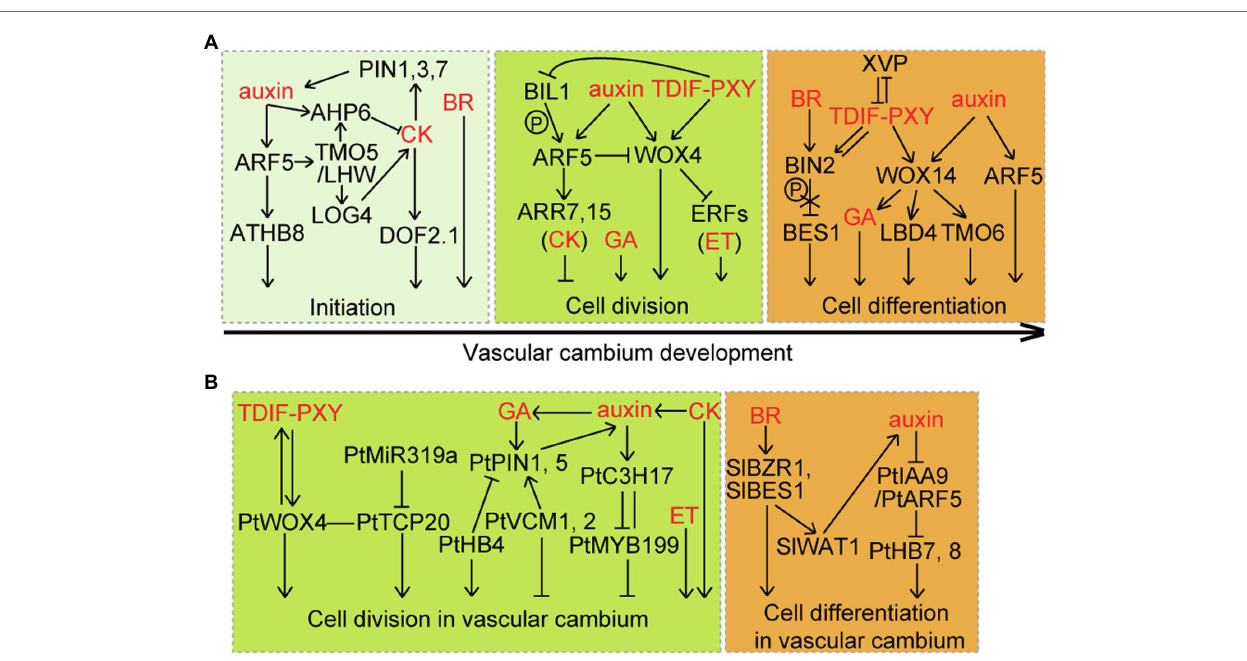
FIGURE 2 | Coordination of multilayered signaling pathways on vascular cambium. (A) In Arabidopsis , vascular cambium initiation and the proliferation and differentiation of cambia derivative cells require a coordination of multiple signals, including auxin, cytokinin (CK), brassinosteroid (BR), gibberellin (GA), ethylene (ET), and TDIF-PXY. TDIF peptides are synthesized in the phloem and move to the cambium at which they bind to the PXY receptor. (B) Cross talk regulation of cell division and differentiation by multiple signals in the vascular cambium of Populus (Pt) and tomato (Sl) stems. There is a similar but more complex regulatory network orchestrating vascular cambium development in Populus than that in Arabidopsis